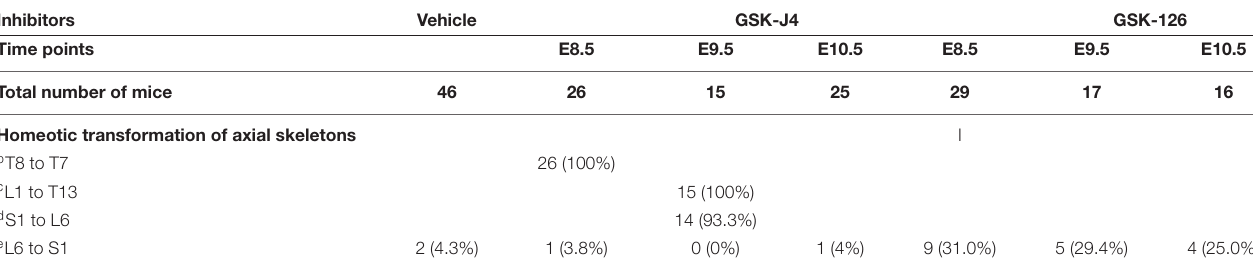
TABLE 2 | Skeletal analysis of E18.5 mouse embryos after treatment by GSK-J4 (50 mg/kg) or GSK-126 (100 mg/kg) at the indicated time points a . Inhibitors